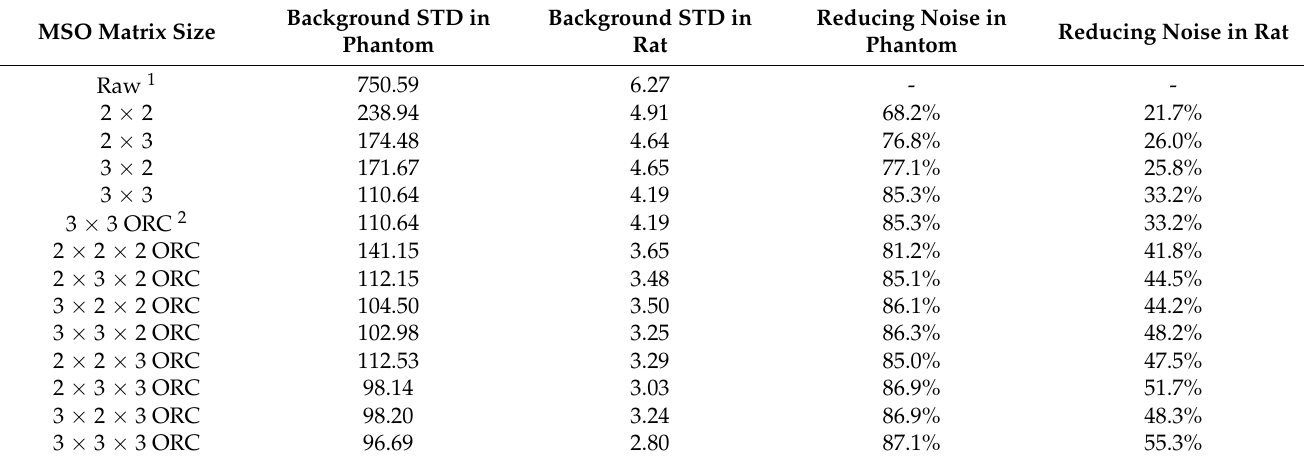
Table 2. The Deluxe Jaszczak phantom and a rat of background standard deviations were obtained by 2D- and 3D-MSO with percentage of reducing noise. The percentage of reducing noise is defined as (Background STD in Raw − Background STD after MSO)/(Background STD in Raw) ×